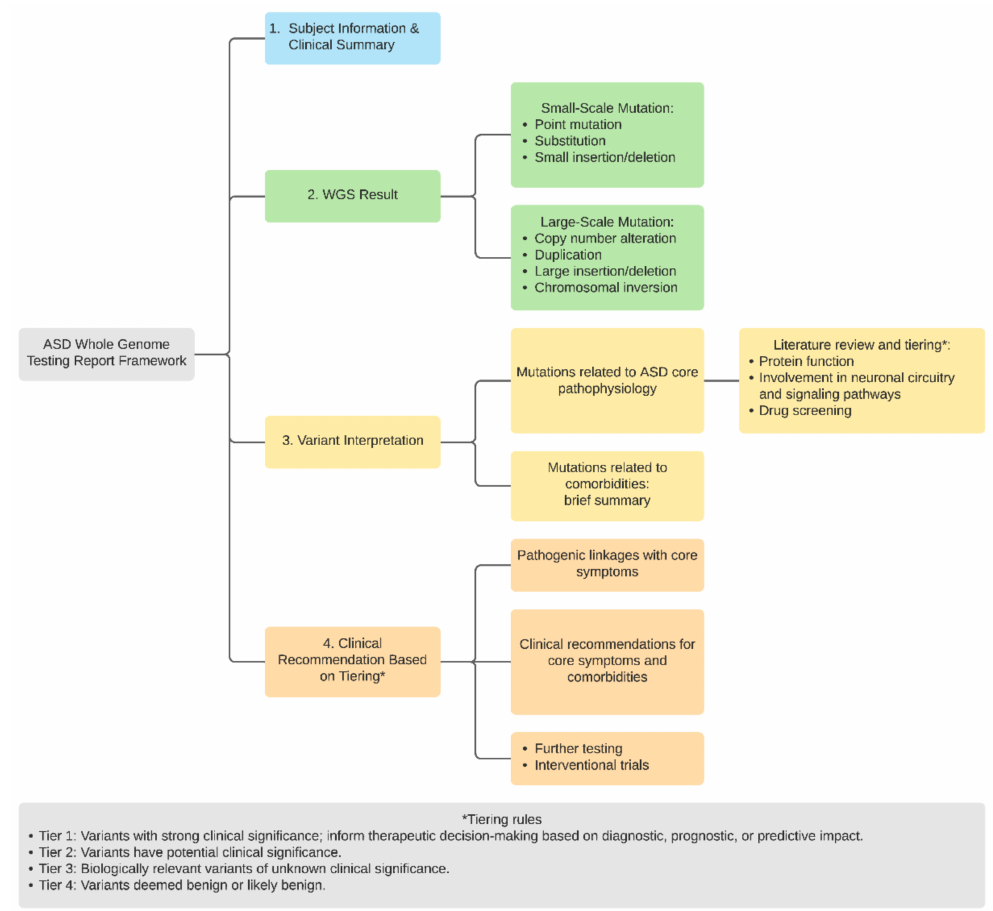
Figure 3. A summary of structure and components for ASD WGS genetic